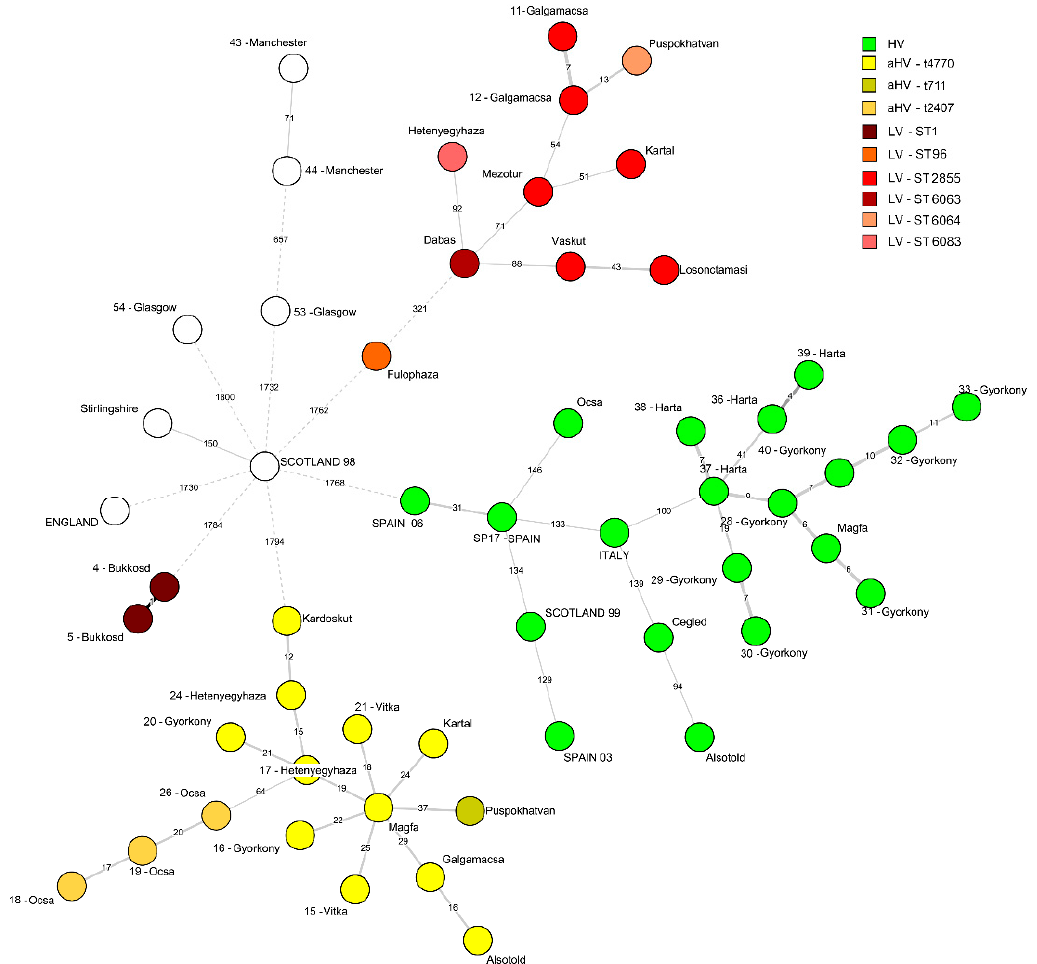
Figure 1. A minimum-spanning tree based on the whole-genome multilocus sequence typing profiles of 54 Staphylococcus aureus isolates of rabbit origin. The minimum spanning tree graph (MST) was created with the BioNumerics v7.6 advanced cluster analysis tool, where branch labels represent the allelic distances shown on a logarithmic scale. The corresponding multilocus sequence typing (MLST) and spa types within a virulence cluster are indicated by different shades of colours. The strains are identified with the city or country (all capital letters) of origin. Isolates are numbered as indicated in Table 1. In case there were multiple isolates from one country, the year or year/number is also provided.